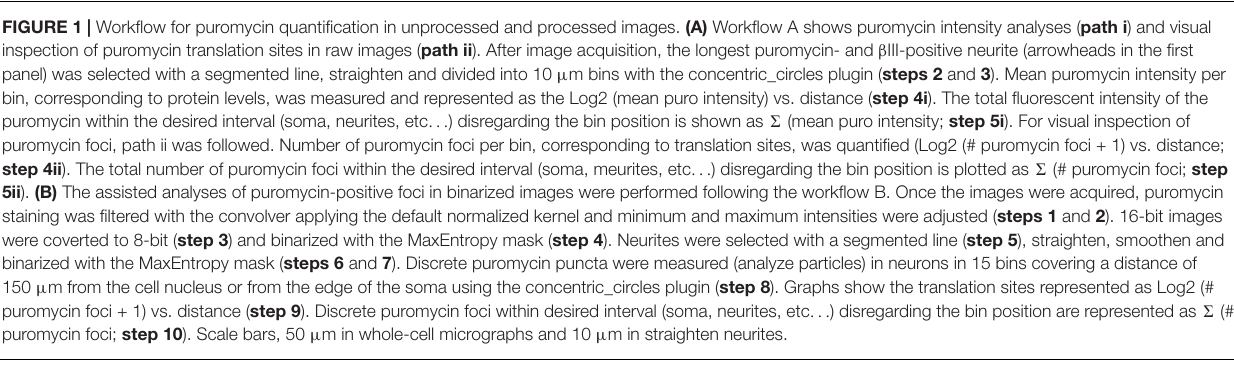
FIGURE 1 | Workflow for puromycin quantification in unprocessed and processed images. (A) Workflow A shows puromycin intensity analyses ( path i ) and visual inspection of puromycin translation sites in raw images ( path ii ). After image acquisition, the longest puromycin- and β III-positive neurite (arrowheads in the first panel) was selected with a segmented line, straighten and divided into 10 µ m bins with the concentric_circles plugin ( steps 2 and 3 ). Mean puromycin intensity per bin, corresponding to protein levels, was measured and represented as the Log2 (mean puro intensity) vs. distance ( step 4i ). The total fluorescent intensity of the puromycin within the desired interval (soma, neurites, etc ... ) disregarding the bin position is shown as (cid:54) (mean puro intensity; step 5i ). For visual inspection of puromycin foci, path ii was followed. Number of puromycin foci per bin, corresponding to translation sites, was quantified (Log2 (# puromycin foci + 1) vs. distance; step 4ii ). The total number of puromycin foci within the desired interval (soma, meurites, etc ... ) disregarding the bin position is plotted as (cid:54) (# puromycin foci; step 5ii ). (B) The assisted analyses of puromycin-positive foci in binarized images were performed following the workflow B. Once the images were acquired, puromycin staining was filtered with the convolver applying the default normalized kernel and minimum and maximum intensities were adjusted ( steps 1 and 2 ). 16-bit images were coverted to 8-bit ( step 3 ) and binarized with the MaxEntropy mask ( step 4 ). Neurites were selected with a segmented line ( step 5 ), straighten, smoothen and binarized with the MaxEntropy mask ( steps 6 and 7 ). Discrete puromycin puncta were measured (analyze particles) in neurons in 15 bins covering a distance of 150 µ m from the cell nucleus or from the edge of the soma using the concentric_circles plugin ( step 8 ). Graphs show the translation sites represented as Log2 (# puromycin foci + 1) vs. distance ( step 9 ). Discrete puromycin foci within desired interval (soma, neurites, etc ... ) disregarding the bin position are represented as (cid:54) (# puromycin foci; step 10 ). Scale bars, 50 µ m in whole-cell micrographs and 10 µ m in straighten